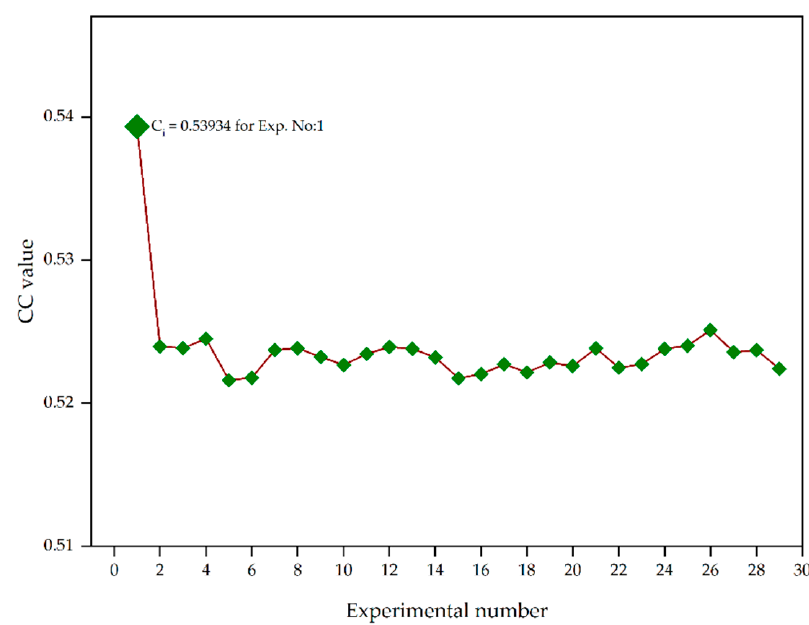
Figure 8. Closeness coefficient values for each experimental specimen.